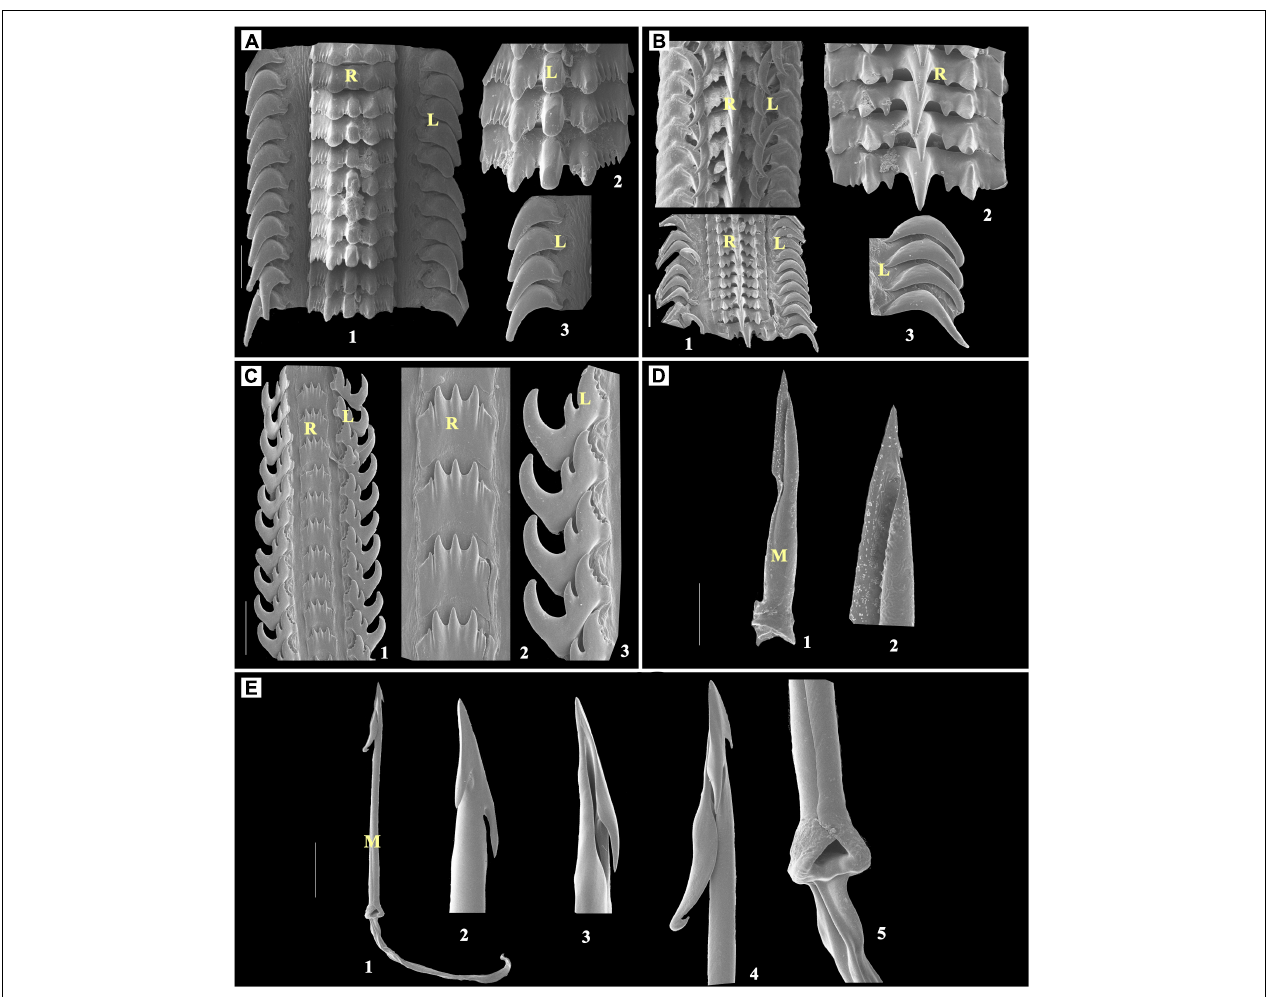
FIGURE 5 | (A) Thais sp., Scale bar: 100 µ m; (B) Tylothais savignyi , Scale bar: 50 µ m; (C) Pollia undosa , Scale bar: 100 µ m; (D) Conus figulinus , Scale bar: 100 µ m; (E) Conus achatinus , Scale bar: 100 µ m; 1: radula; 2–5: enlarged part of radula; R, rachidian teeth; L, lateral teeth; M, marginal